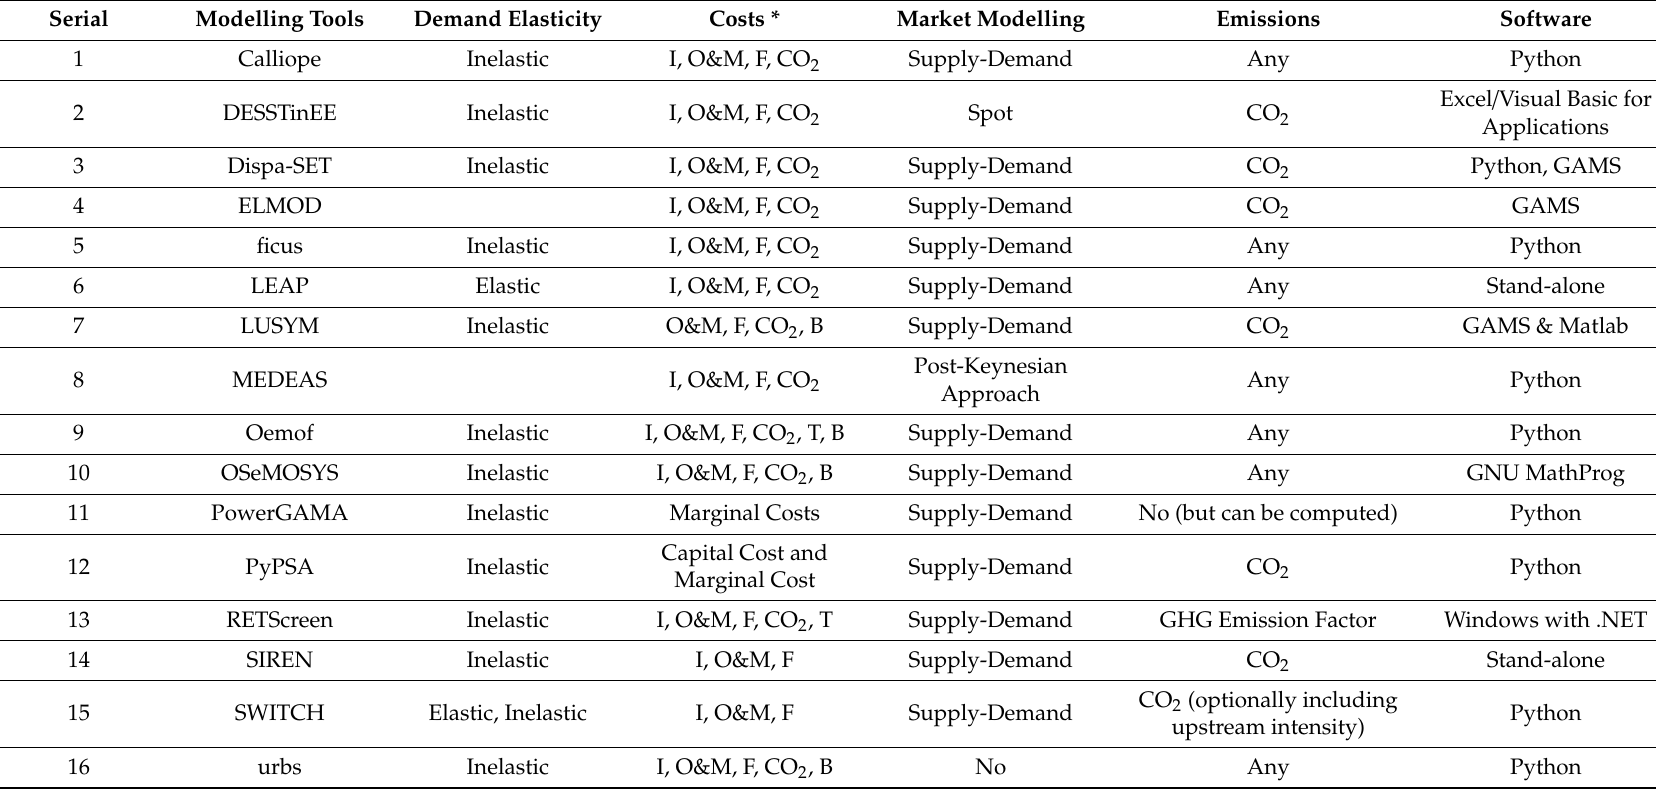
Table A4. Comparison between the 16 selected modelling tools (Part 3). Adapted from [98] and